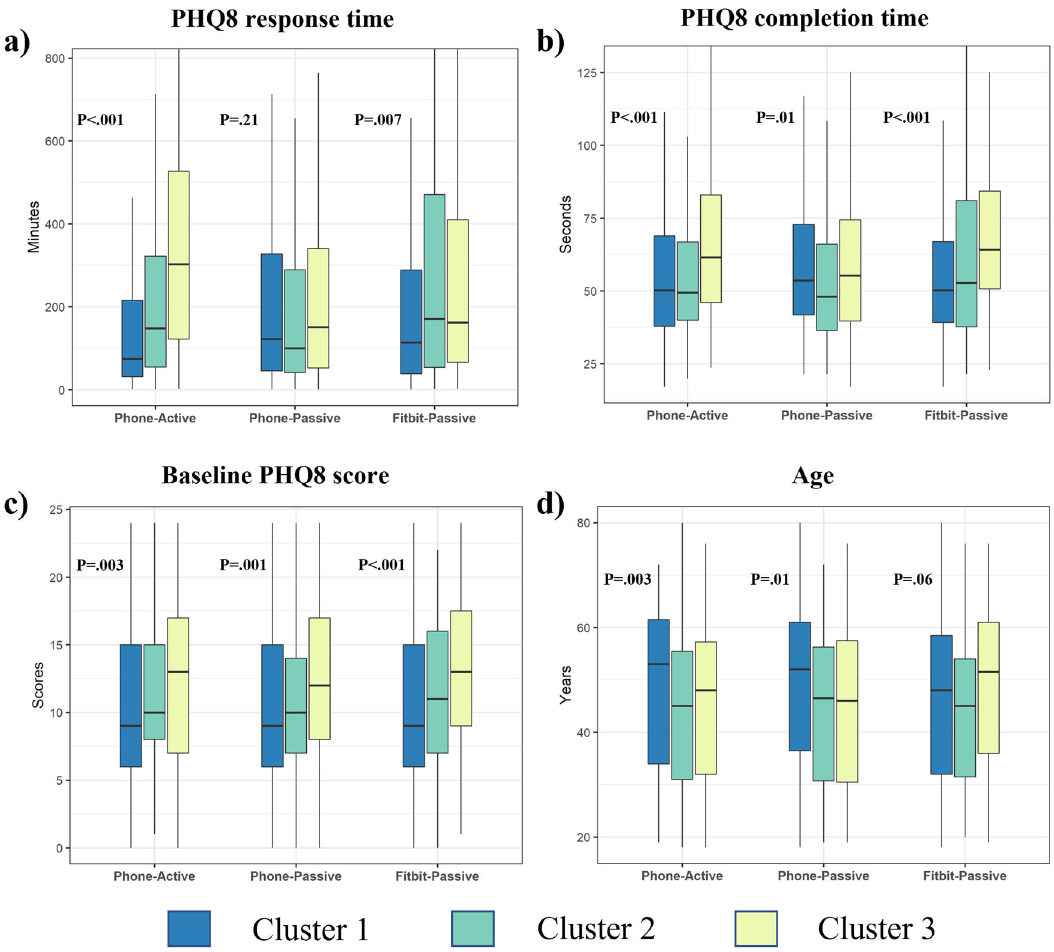
Fig. 3 Signi fi cant factors impacting the long-term engagement patterns. Signi fi cant differences in participants ’ ( a ) survey response time, ( b ) survey completion time, ( c ) baseline depression symptom severity, and ( d ) age across three long-term engagement patterns (Cluster 1, Cluster 2, and Cluster 3) for Phone-Active, Phone-Passive, and Fitbit-Passive data streams, respectively. Note: Cluster 1, Cluster 2, and Cluster 3 represent the most engaged, medium engaged, and least engaged patterns shown in Fig. 2b. The centerline of the boxplots shows the median value of the factor across participants for each cluster, the box indicates the interquartile range (IQR) from the 25th (Q1) to 75th (Q3) percentiles, and the whiskers represent points within Q1 − 1.5*IQR and Q3 + 1.5*IQR. All p values were calculated by Kruskal-Wallis